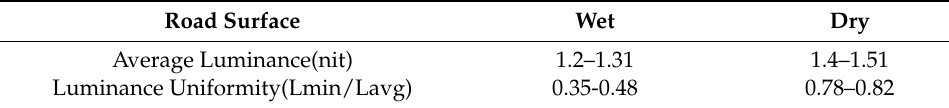
Table 7. The luminace level of Sect. 5 of Gaotie South